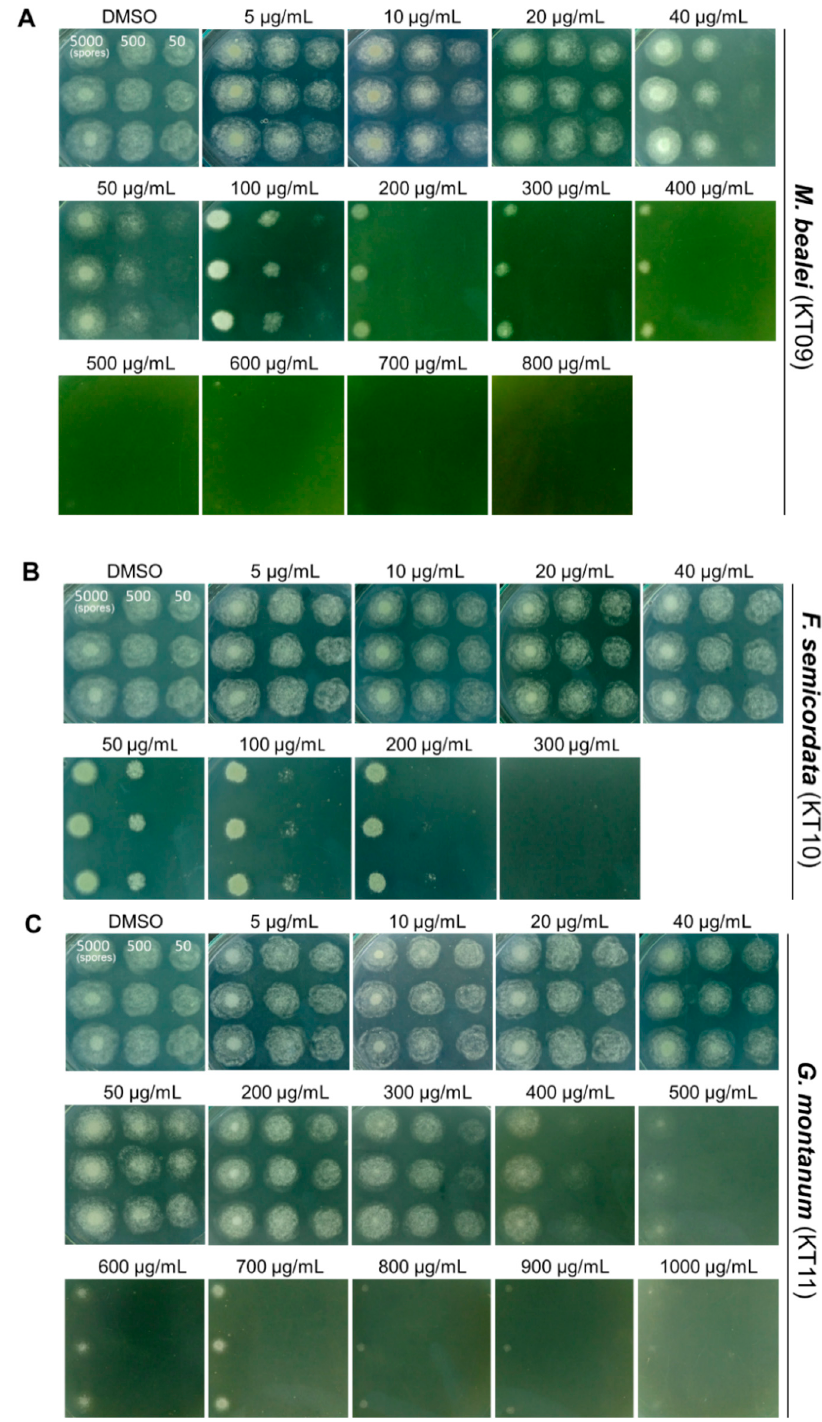
Figure 2. Assays for minimal inhibitory concentrations of the selected crude extracts, including ( A ) M. bealei (KT09), ( B ) F. semicordata (KT10), and ( C ) G. montanum (KT11) against P. digitatum using the microdilution method. The crude extracts were added to the PDA medium to obtain final concentrations of 5–1000 µ g/mL. DMSO was used as the negative control. Fungal spores were prepared at concentrations of 10 4 , 10 5 , and 10 6 spores/mL. Then, 5 µ L volumes of the spore suspensions (equal to 50, 500, and 5000 spores) were spotted onto the PDA plates. Plates were incubated at 25 ◦ C for 3